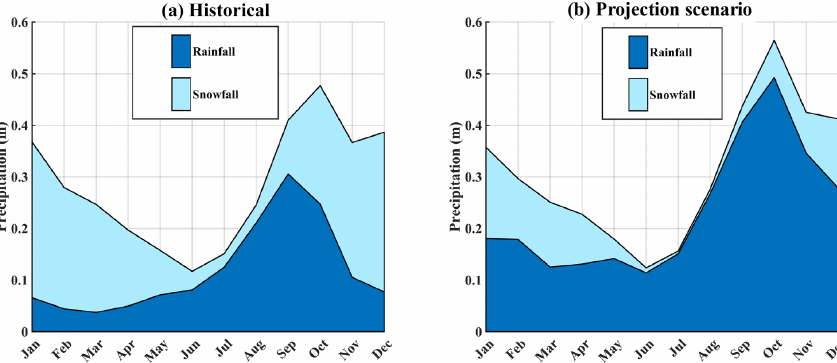
Figure 4. Precipitation climatologies. (a) The domain-aggregated GBNPP historical (1979–2015) precipitation climatology, partitioned into snowfall and rainfall constituents. (b) The domain-averaged and domain-aggregated GBNPP projection scenario (2070–2099) precipitation climatology, partitioned into snowfall and rainfall constituents. For all figures, uncertainties are not shown to facilitate readability.